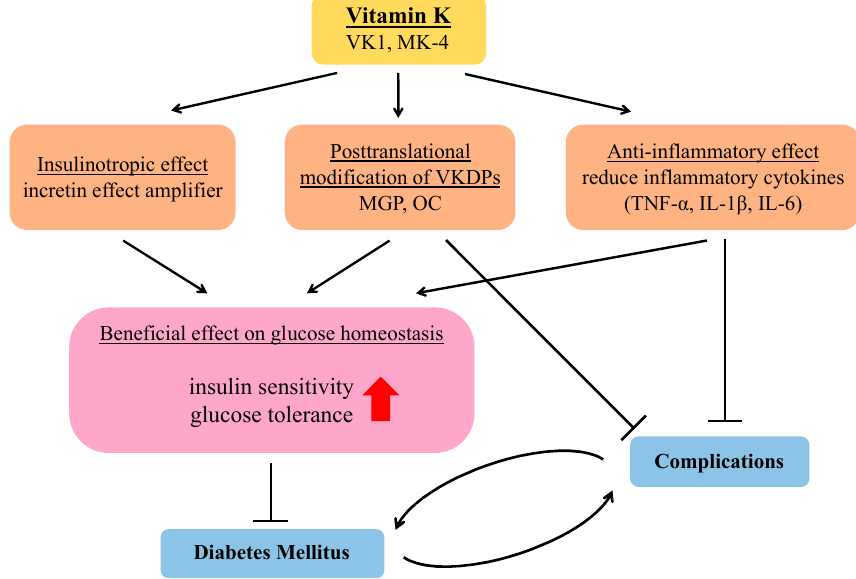
Figure 2. Schematic illustration of the plausible mechanisms of VK on insulin response and glycemic status. MGP: matrix Gla protein; OC: osteocalcin; TNF- α : tumor necrosis factor α , IL: interleukin.